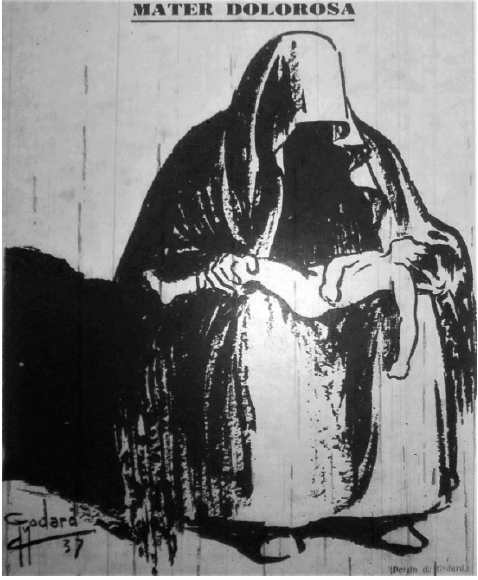
Figure 7. Godard. “Our Lady of Sorrows.” La Patrie Humaine. 26 March 1937. Ink on Paper. Bibliothèque Nationale de France.